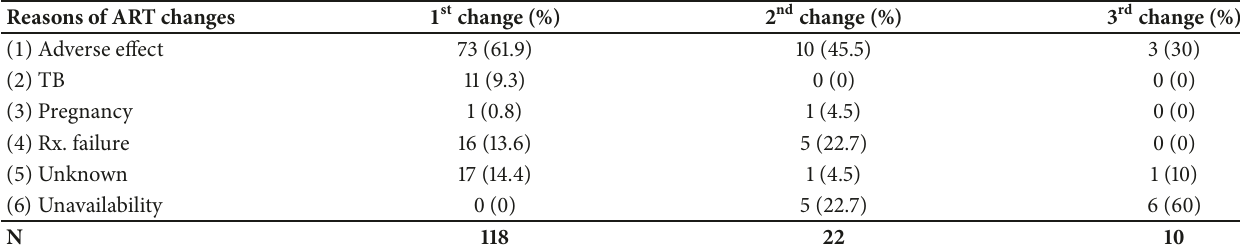
Table 3: Documented reasons for changing ART regimens at University of